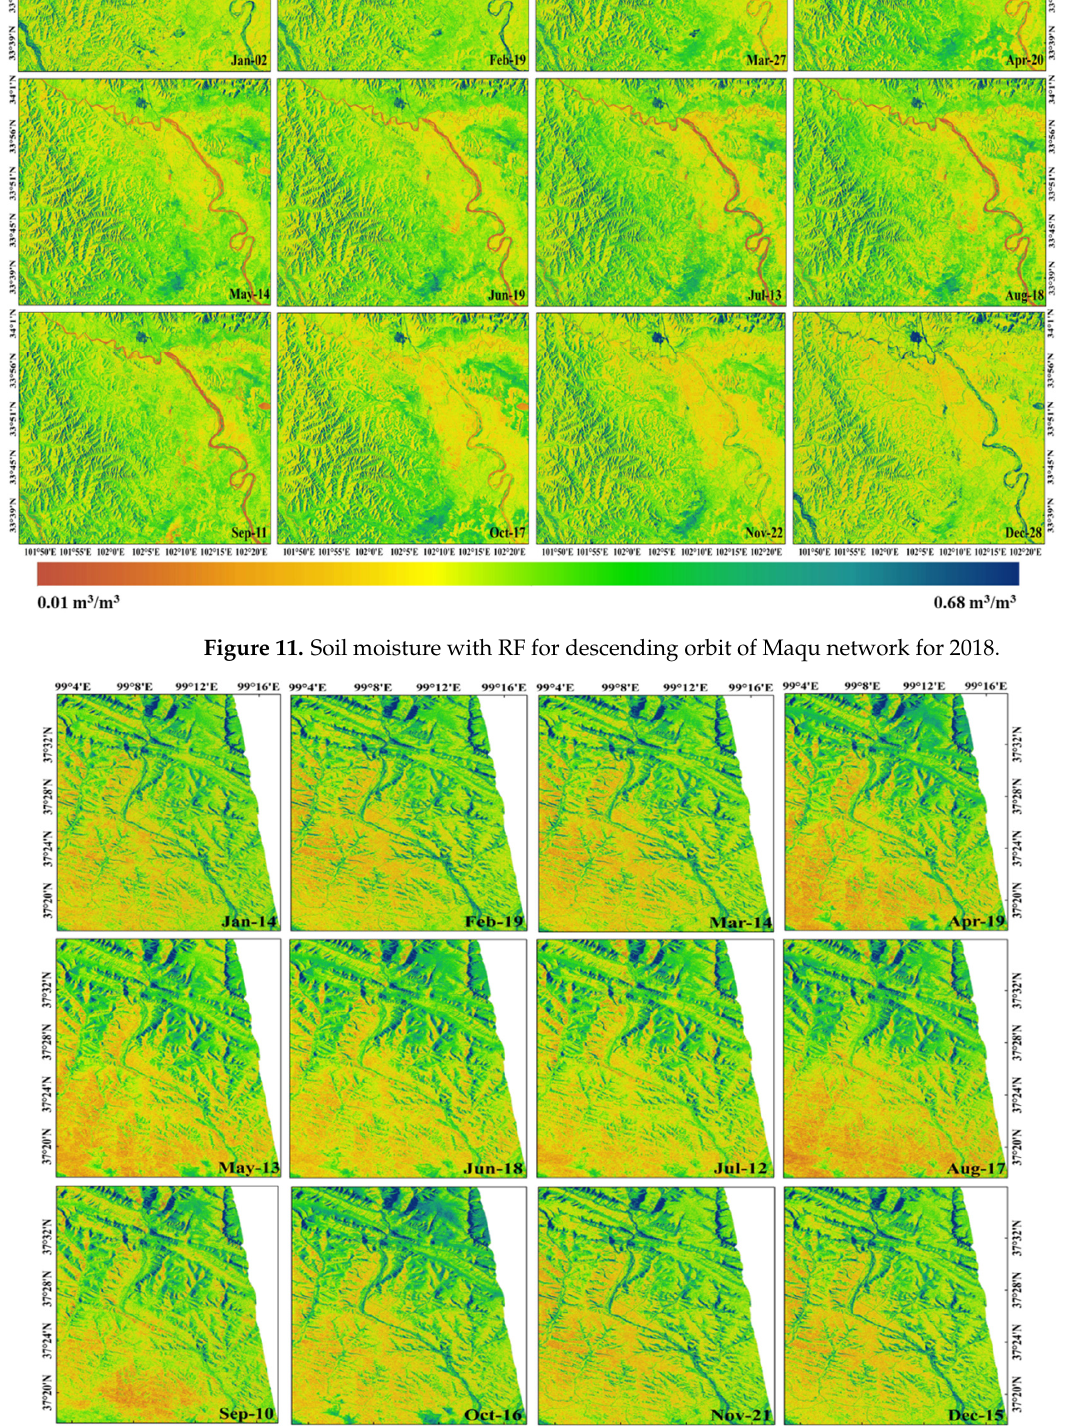
Figure 12. Soil moisture with RF for ascending orbit of Tianjun network for 2020.